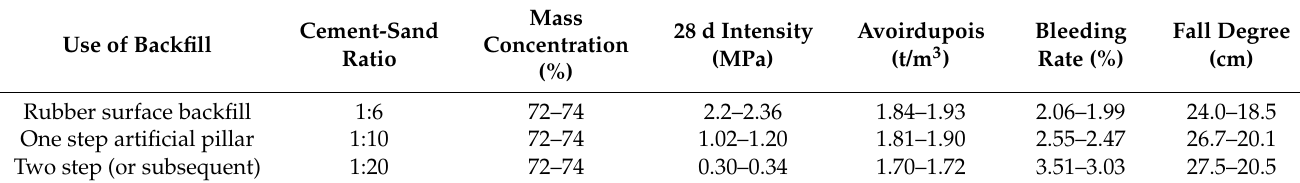
Table 1. Design of full tailings backfill ratio and performance parameters in Baoshan Mine.